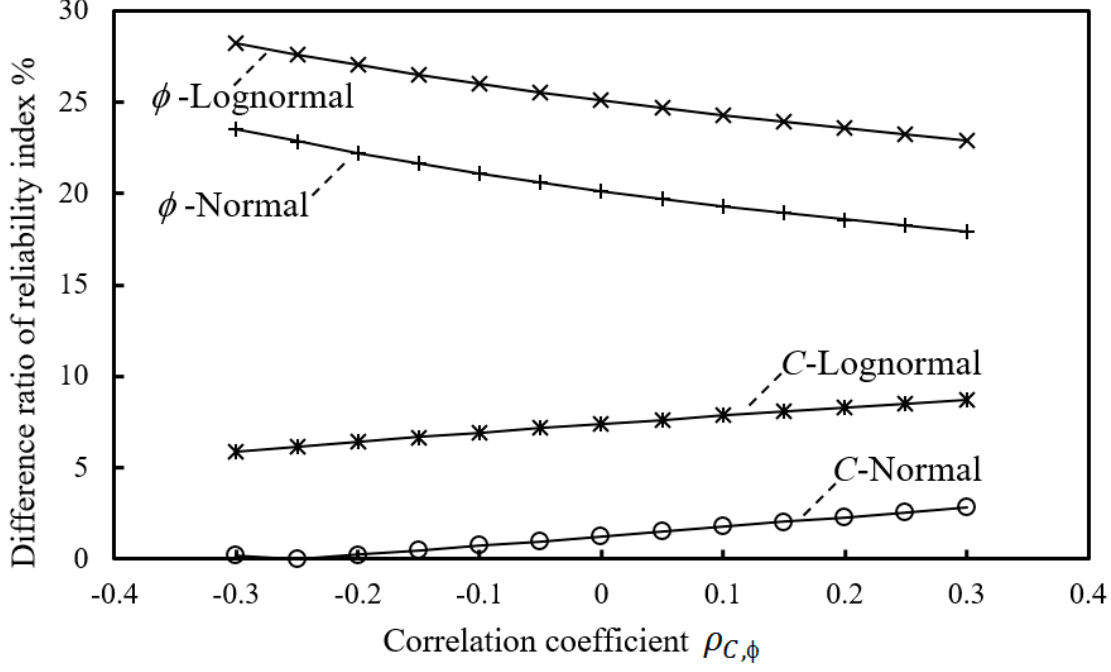
Figure 10. Cross-influence induced by the switch of probability distribution patterns.